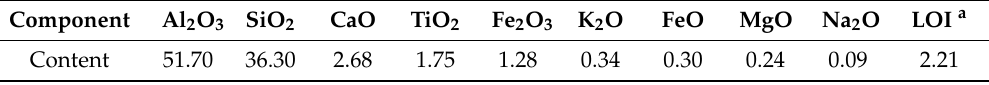
Table 1. Composition of the coal fly ash (CFA)